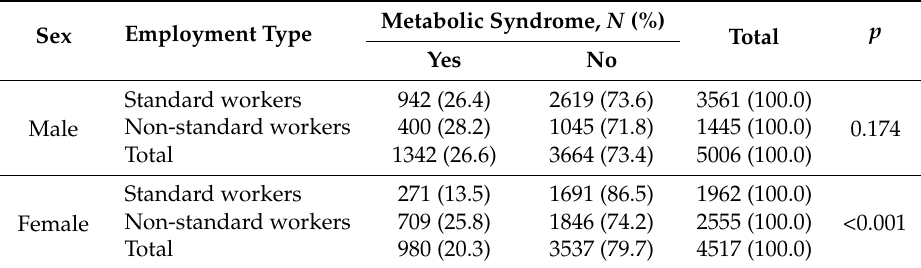
Table 2. Metabolic syndrome prevalence according to sex and by the standard of work.